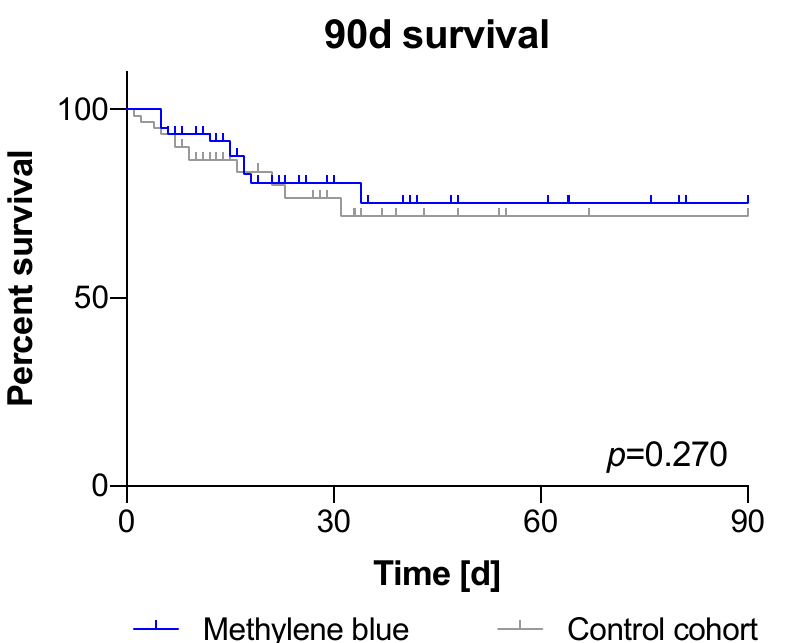
Figure 3. Ninety-day survival after vasoplegic syndrome: The 90-day survival did not differ significantly (MB: 81.7% vs. CG: 80%; p = 0.270).